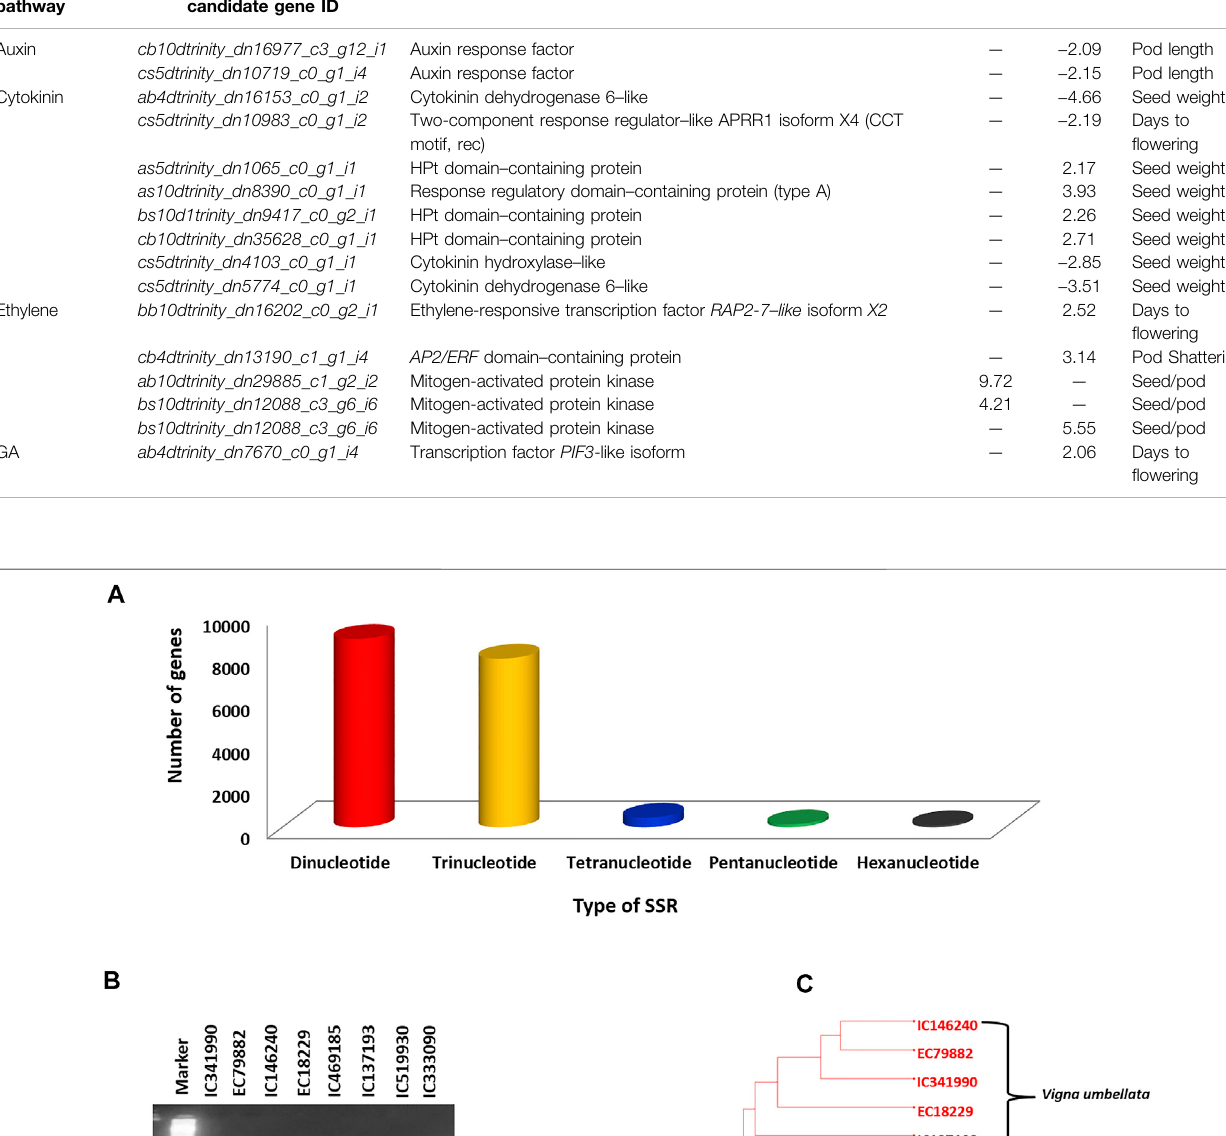
TABLE 4 | List of candidate genes matched with our KEGG pathway results. KEGG pathway